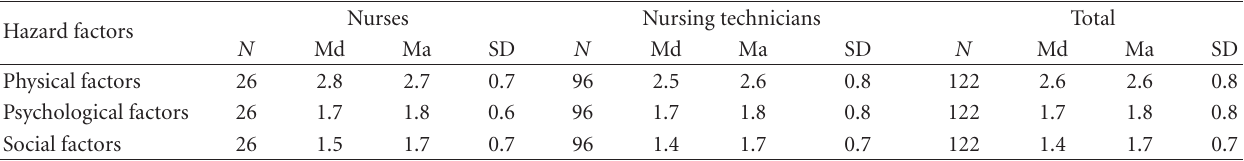
Table 1: Medians, means, and standard deviations of physical, psychological, and social hazard factors among nurses and nursing technicians, Bras´ılia, 2007.